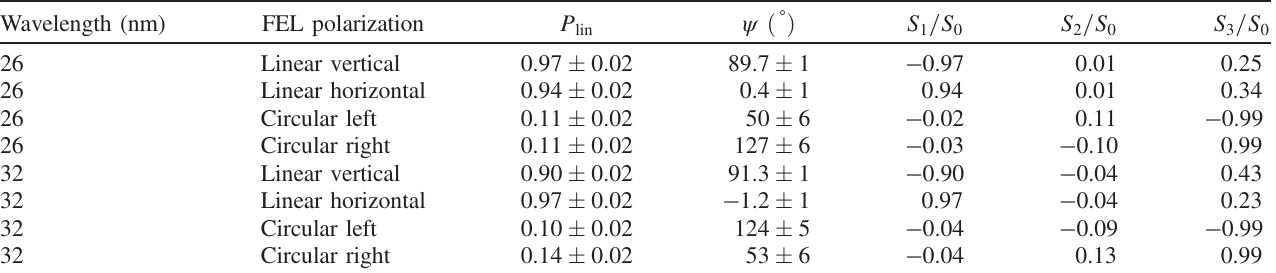
TABLE VI. Summary of the measured average degree of polarization for various FEL configurations. S 1 and S 2 are extracted from P through trigonometry, and S 3 is calculated assuming perfectly polarized light; the measurement setup cannot distinguish between unpolarized and circularly polarized light.